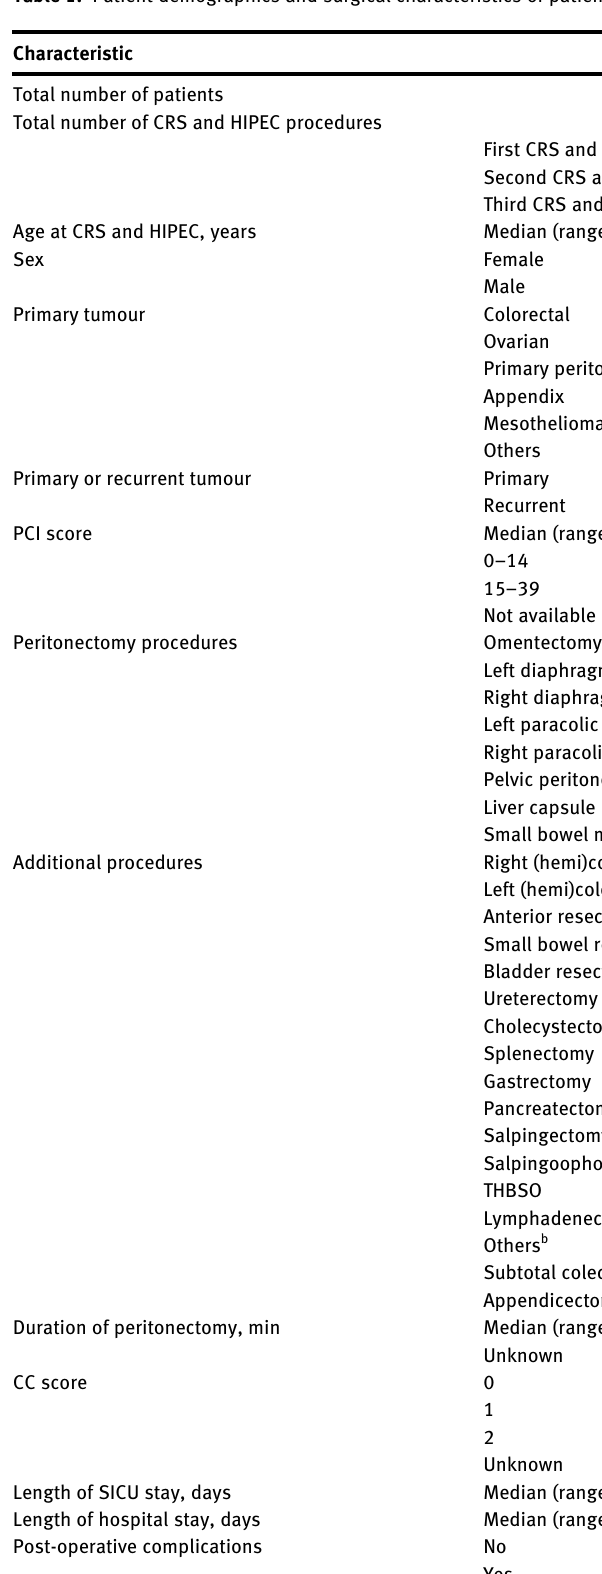
Table  : Patient demographics and surgical characteristics of patients who underwent CRS and HIPEC, n= 